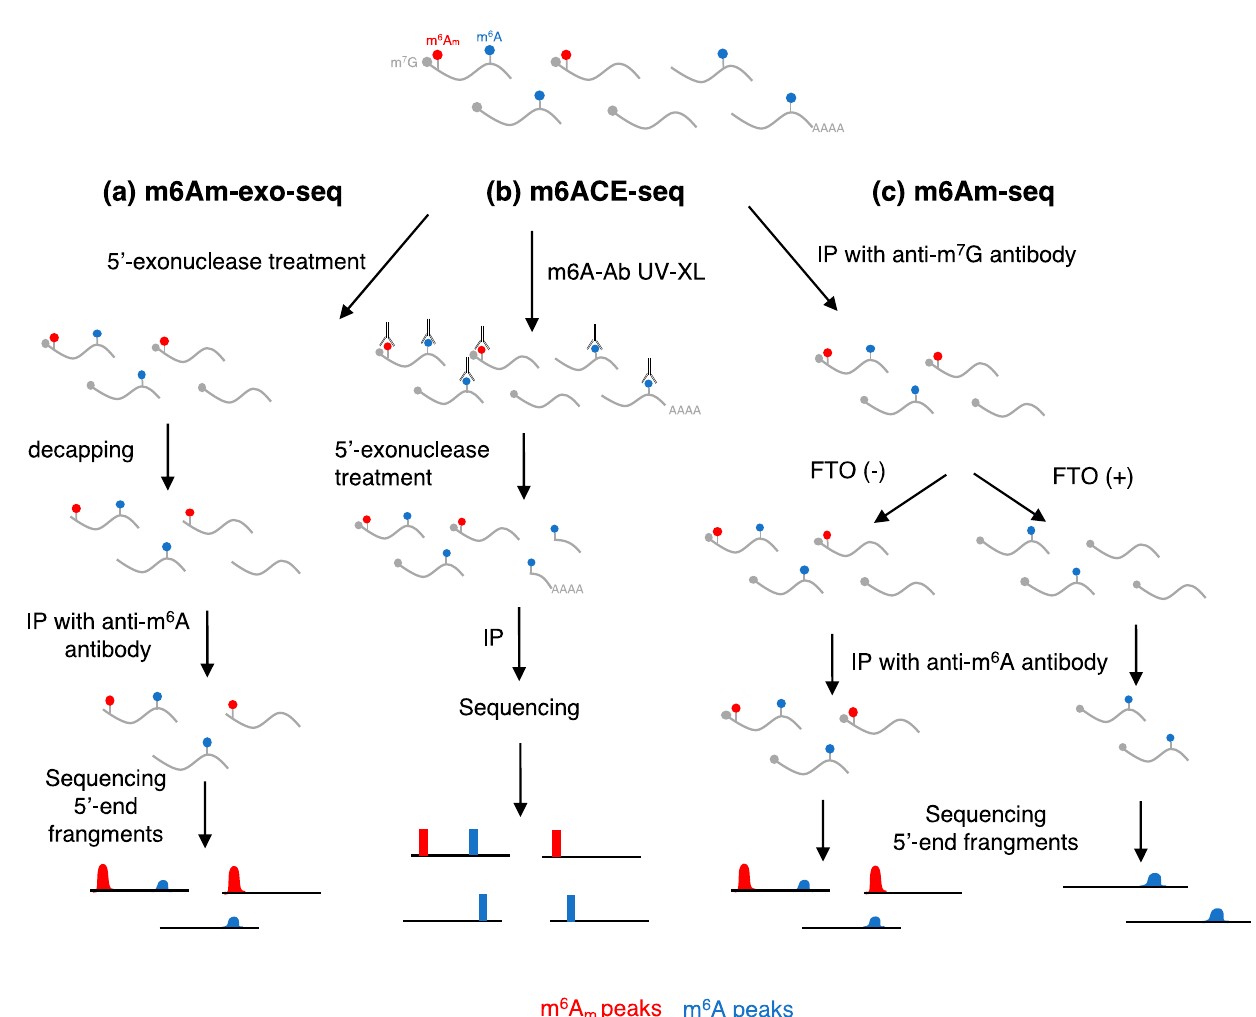
Figure 2. Sequencing methods for m 6 A m mapping. All methods work on fragmented RNA. ( a ) In the